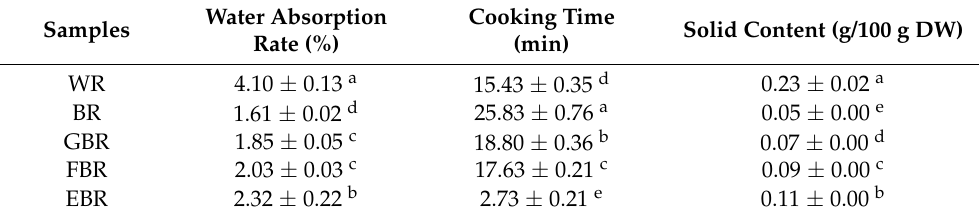
Table 3. Cooking properties of different brown rice